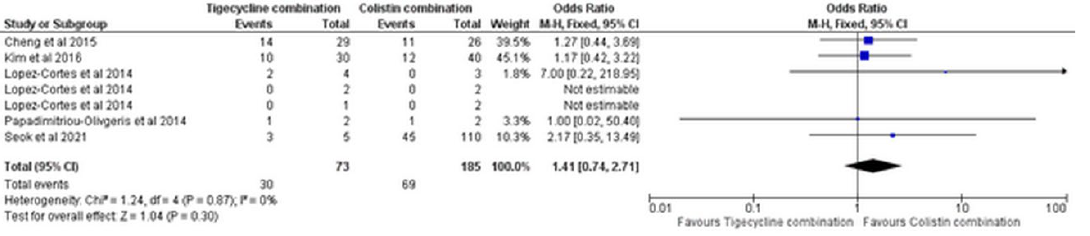
Figure 11. Thirty-day mortality of tigecycline combination versus colistin combination [14,17,20,21,24]. Similarly, based on four studies [16,19–21], the in-hospital mortality did not statisti- cally significantly differ between the colistin combination versus tigecycline combination (OR = 1.21, 95% CI [0.73, 1.98], p = 0.46), Figure 12, with no significant heterogeneity (I 2 = 0%, p = 0.57).